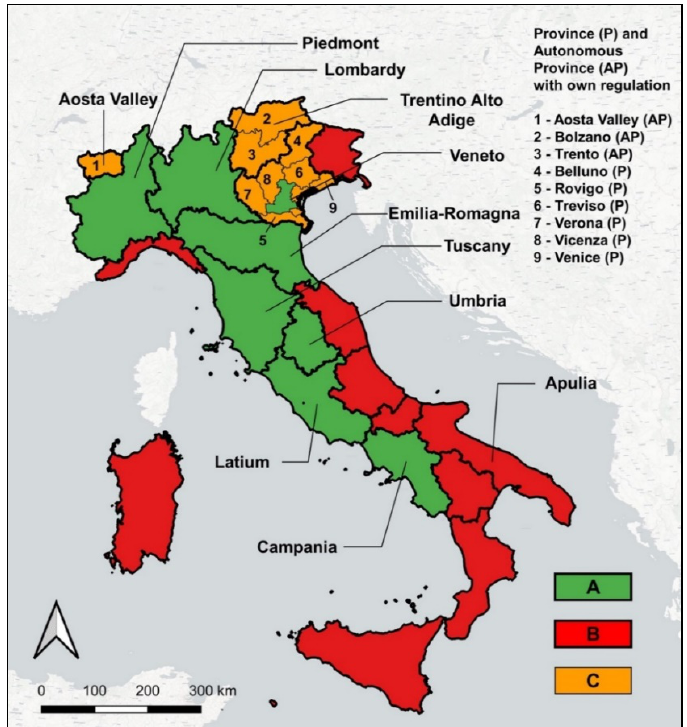
Figure 2. Overview of the low enthalpy geothermal energy (LEG) Italian regulation. ( A ) region with regulation; ( B ) region without regulation; ( C ) province with regulation.